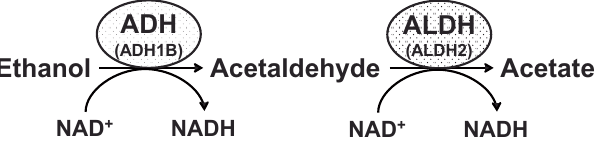
Figure 1. Ethanol oxidization by ADH and ALDH. Ethanol is oxidized to acetaldehyde by alcohol dehydrogenase (ADH), and acetaldehyde is further metabolized to acetate by aldehyde dehydrogenase (ALDH). These oxidization activities largely depend on ADH1B and ALDH2, respectively. The enzymatic activities of ADH1B and ALDH2 depend on common dysfunctional variants, rs1229984 (His48Arg) and rs671 (Glu504Lys) in East Asians, respectively. The A/A (His/His) or A/G (His/Arg) genotype of rs1229984 has been reported to produce 40-fold faster ethanol oxidation by ADH1B than the G/G (Arg/Arg) genotype. Individuals with heterozygotes (Lys/Glu) of rs671 have only 6.25% of the enzyme activity of those with normal ALDH2 (Glu/ Glu), and those with homozygotes (Lys/Lys) show almost no activity. Therefore, the Lys carrier of ALDH2